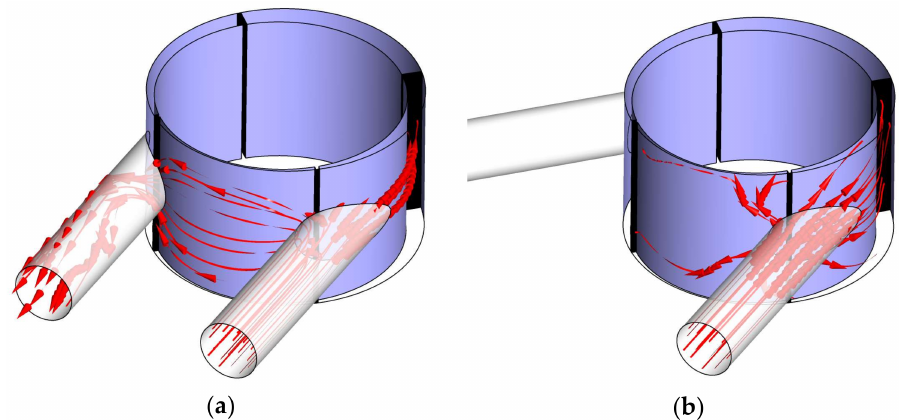
Figure 14. The visualization of leakage from the inlet to the outlet port of the expander: ( a ) present design; ( b ) improved